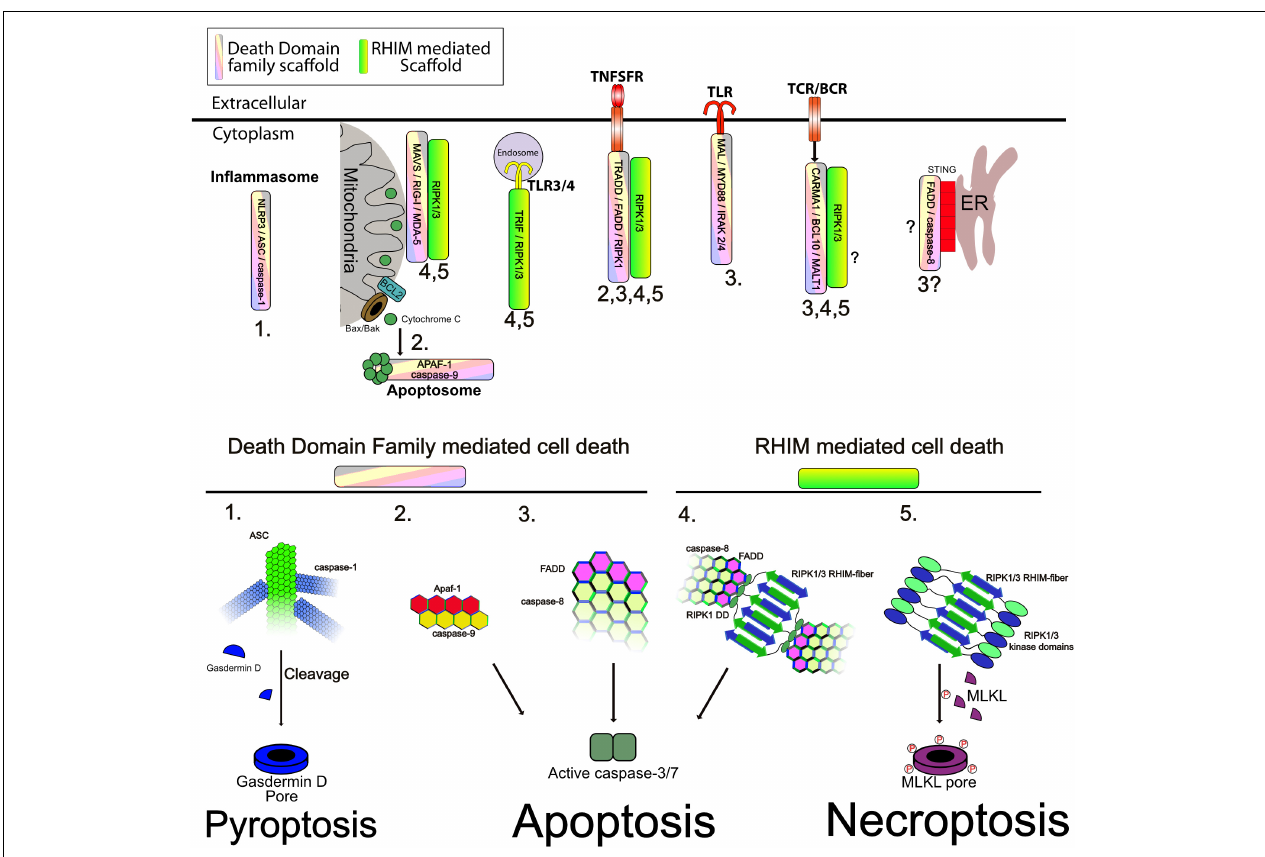
FIGURE 4 | Supramolecular signaling complexes can activate cell death. (Upper) The indicated complexes and the respective scaffolds recruited are indicated. Numbers correspond to the modes of cell death shown in the lower panel ad indicate the modes shown to be triggered by the respective complexes. (Lower) Different modes of cell death and the role of the respective scaffold in activating caspases, or RIP kinases is shown. (1) Inflammasomes assemble a core filament of ASC which in turn recruits filaments of caspase-1, to cluster it and trigger its activation. Active caspase-1 then cleaves Gasdermin D to allow the cleaved form to assemble into multimeric pores in the plasma membrane, causing pyroptosis. (2) Release of cytochrome C through Bax/Bak pores on the mitochondrial outer membrane triggers formation of the apoptosome. The apoptosome consists of a core of APAF1 and caspase-9 interacting through CARD–CARD interactions as indicated. This allows activation of caspase-9. Caspase-9 then cleaves and activates caspase-3/7 to trigger apoptosis. (3) Caspase-8 clustering onto FADD causes its autoactivation. Clustering is mediated through DED–DED interactions between FADD and caspase-8 and caspase-8 itself (not shown is cFLIP which can commingle with caspase-8 to regulate its activation). Active caspase-8 can cleave caspase-3/7 and trigger apoptosis. This scaffold can be activated by numerous receptors as indicated. (4) Recruitment and activation of RIPK1/3 through RHIM–RHIM mediated amyloid fibers can trigger FADD recruitment and clustering